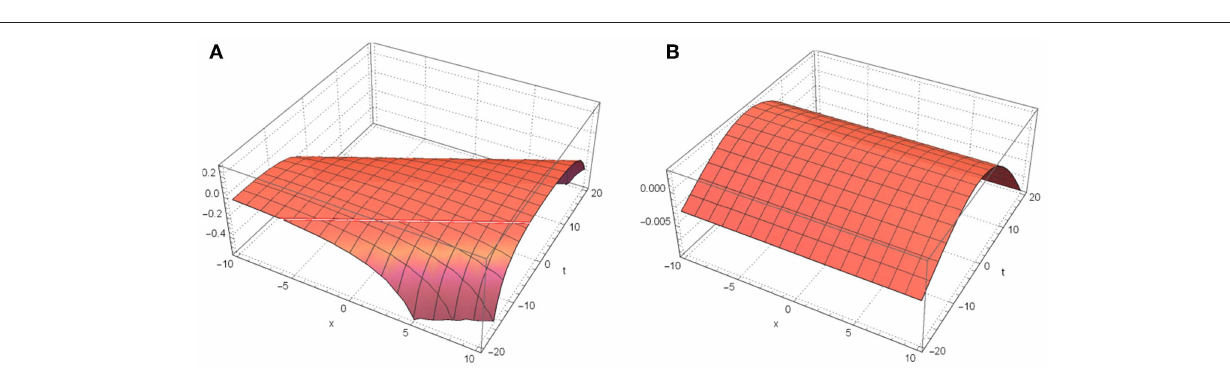
FIGURE 3 | Dynamic behavior of u 9 ( x , t ), and u 10 ( x , t ) for k 2